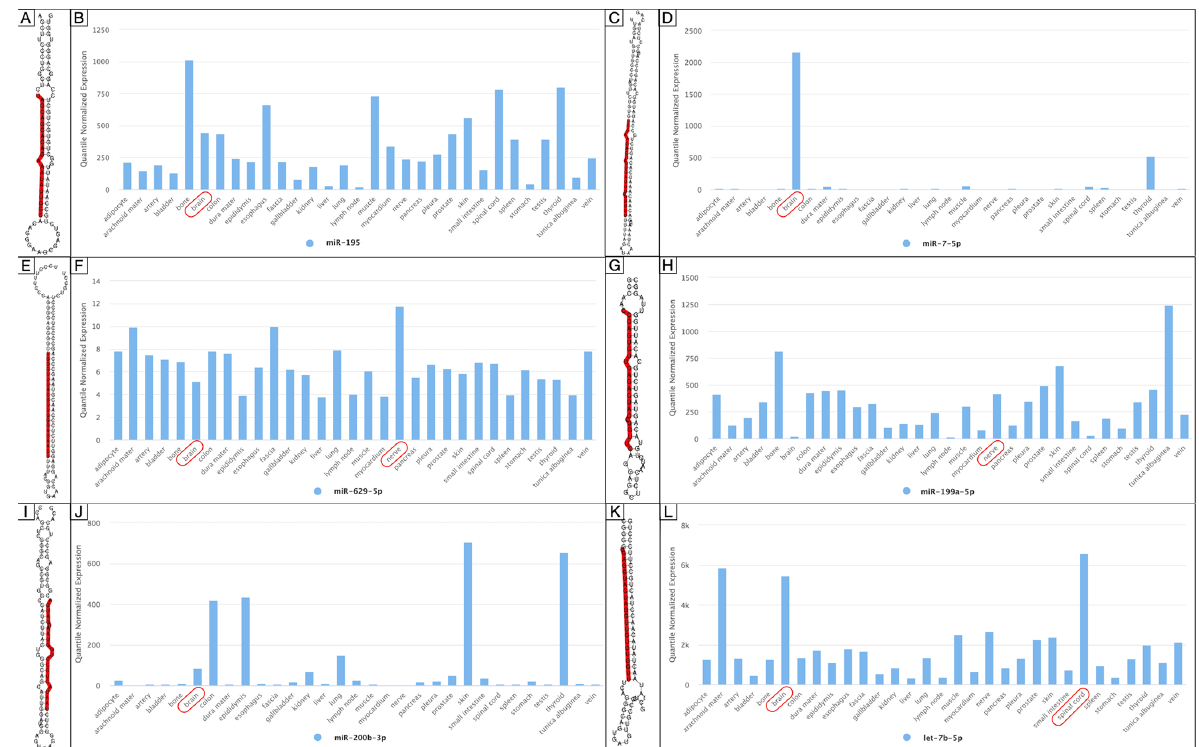
Figure 7. RNA secondary structure and the quantile normalized expression in human organs for miR-195* ( A , B ), miR-7-5p ( C , D ), miR-629-5p ( E , F ), miR-199a-5p ( G , H ), miR-200b-3p ( I , J ), and let-7b-5p ( K , L ). Red circled text shows the nervous system structures involved. Furthermore, the bioinformatic analysis on the KEGG database retrieved a functional enrichment appraisal of miRNA-related intracellular signals involved in the pathogenesis of bAVMs [28]. The main pathway, modulated by the miRNAs, was the VEGF, which regulates the aberrant angiogenesis and remodeling of the nidus (Figure 8A).